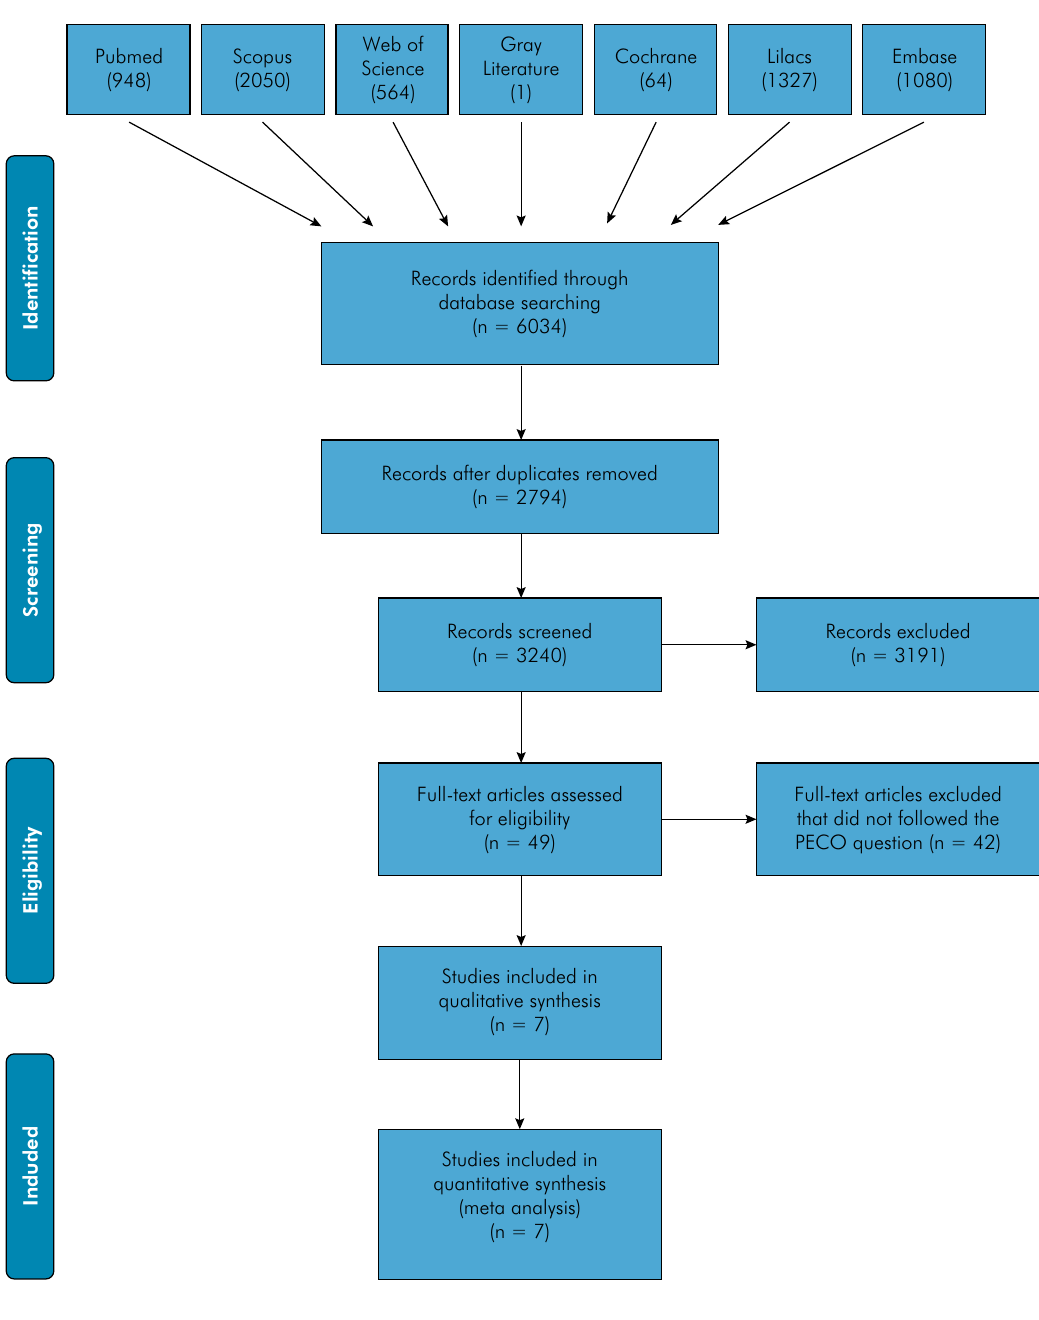
Figure 1. Flow diagram of the literature search based on the PRISMA